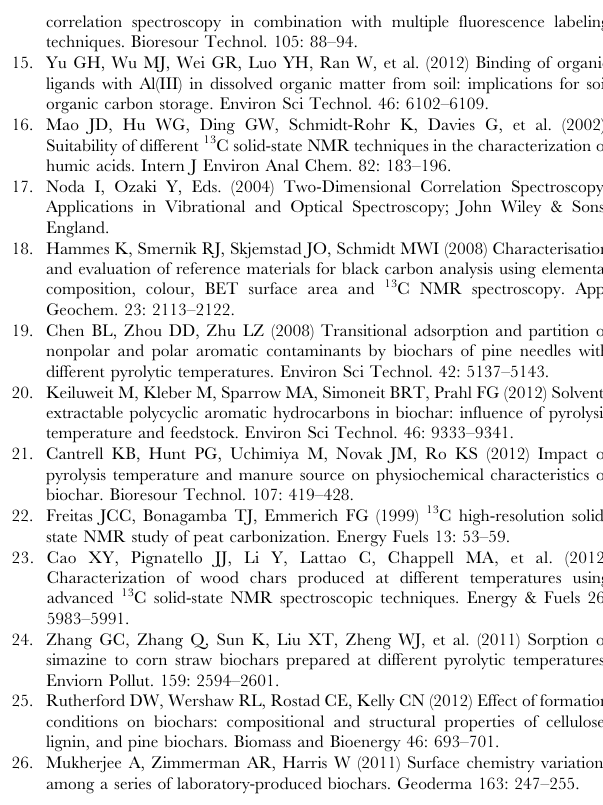
Table S1 Regression Analysis between Functional Groups (I/I 0 ) with Charring Temperatures (T). Table S2 Regression Analysis between Biochar Proper- ties (pH and EC) and Functional Groups (I/I 0 ) Derived from Solid State 13 C NMR Spectroscopy.